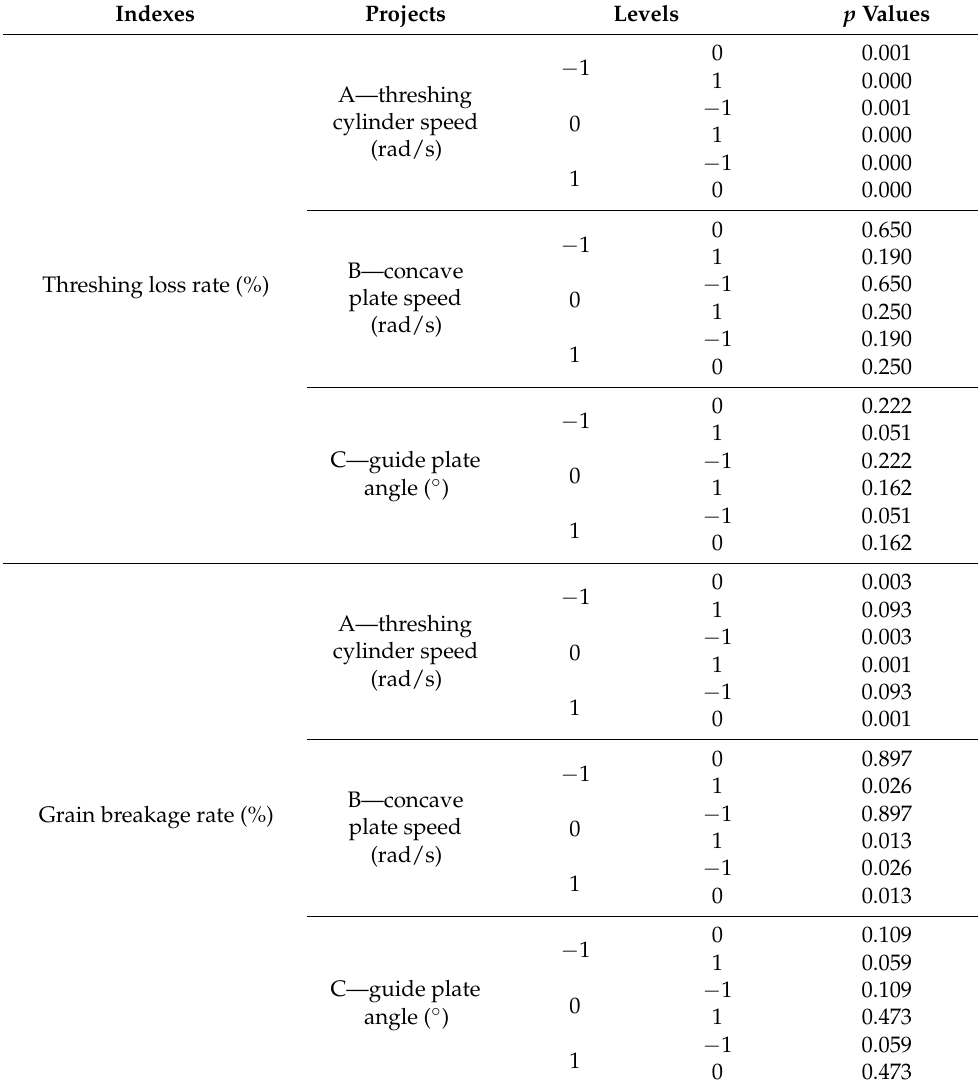
Table 11. Results of Post Hoc tests of